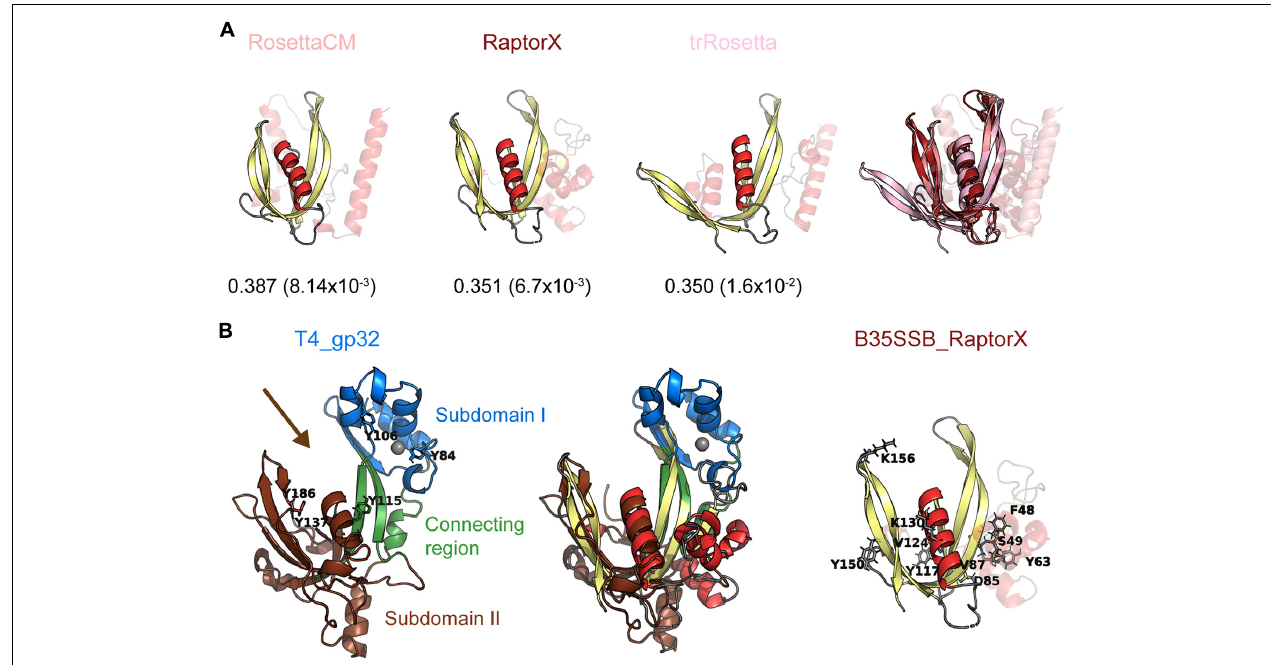
FIGURE 7 | B35SSB and related proteins can constitute a novel SSB fold, divergent to known OB-folds. (A) Best structural models of B35SSB, obtained with three different methods as indicated. The N-terminal 76 residues are displayed as semitransparent to show clearly the C-terminal domain rich in β -sheets that might be reminiscent of an OB-fold. The VoroMQA Score and the model confidence E -value from ModFold8 server are also shown. Note that VoroMQA considers “likely good models” those with Score > 0.4 and “likely bad models” when the Score is less than 0.3. The rightmost figure represent a structural alignment of the three models. (B) Structural alignment of T4 SSB and RaptorX model of B35SSB (middle). Cartoon representation of T4 gp32 (PDB ID 1GPC) is shown on the left. Protein subdomains are colored as in Shamoo et al. (1995) and tyrosine residues involved in DNA binding (Shamoo et al., 1989) are highlighted as sticks. The zinc cation bound to T4 gp32 Subdomain I is represented as a gray sphere. The arrow marks the DNA binding cleft. The right image represents the B35SSB model with the residues analyzed displayed as